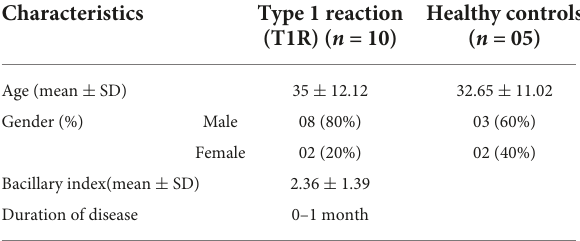
TABLE 1 Demographic characteristics of leprosy patients and healthy controls.